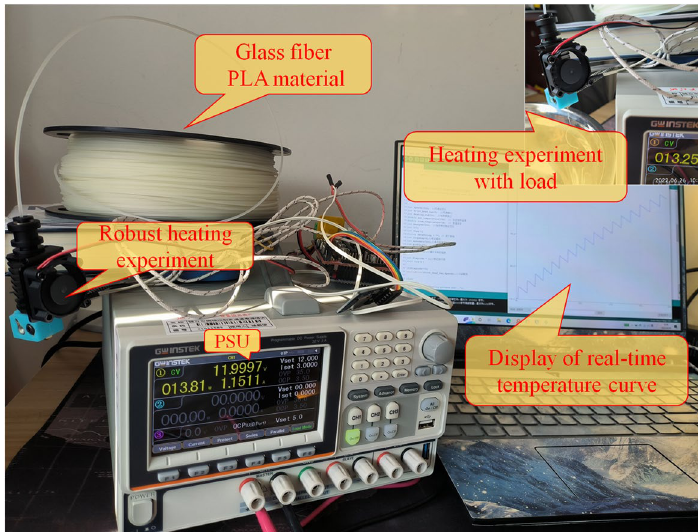
Fig. 4 Load test of GF material electrothermal fuzzy